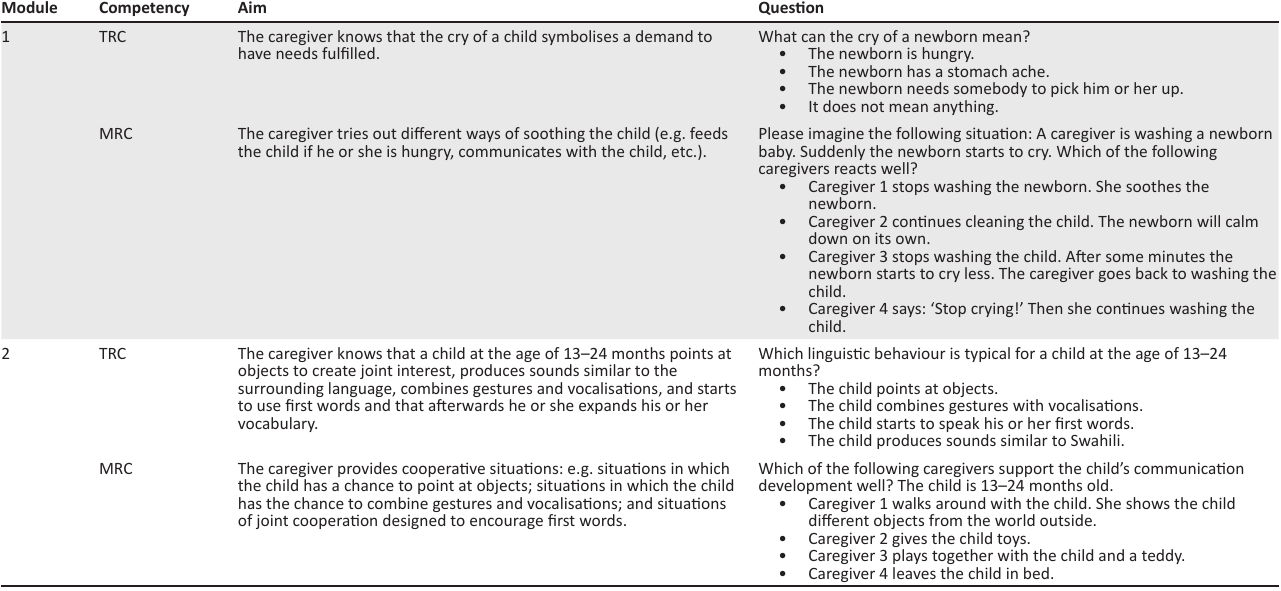
TRC, theoretical relational competency; MRC, methodological relational